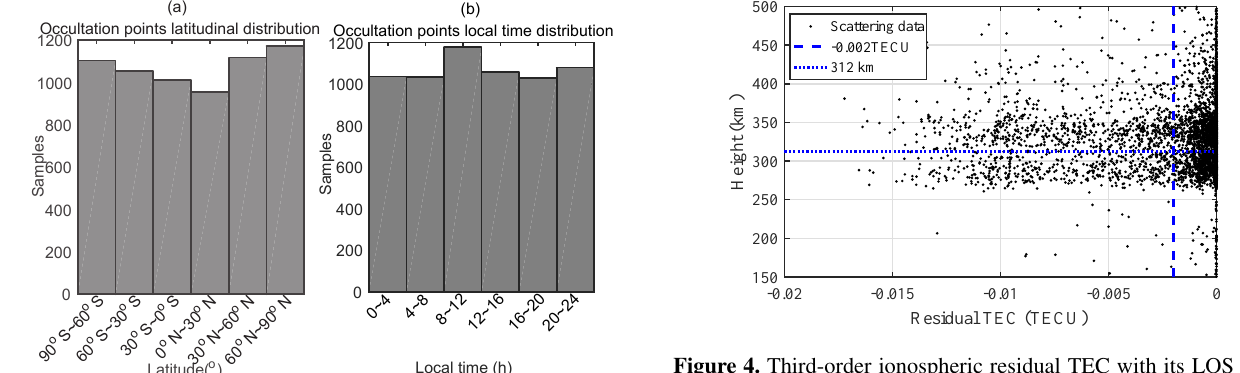
Figure 4. Third-order ionospheric residual TEC with its LOS tan- gent point